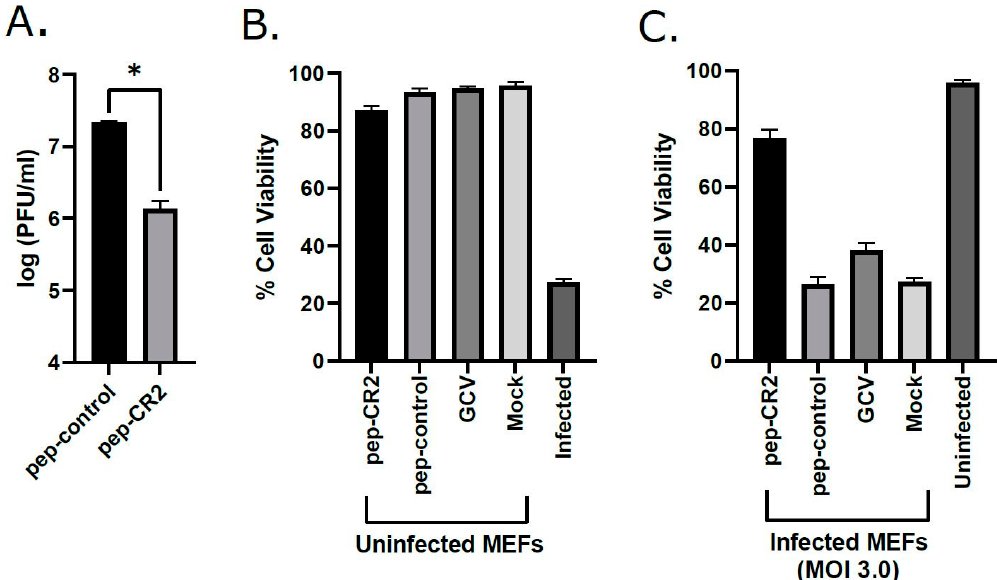
Figure 7. ( A ) Inhibition of MCMV growth upon pep-CR2 treatment. MEF cells were pretreated with 10 μ M concentration of pep-CR2 and pep-control (in triplicates) and infected with MCMV at an MOI of 3.0. Cells were harvested at 3 dpi and virus titers were assessed on MEFs. Data were analyzed by Student’s t-tests, comparing the means of pep-control and pep- CR2. Standard error of mean was plotted as error bars. A p value of <0.05 was considered significant. An asterisk (*) indicates significant inhibition compared to wild type. Cell viability (%) in ( B ) pep-CR2-treated uninfected MEFs vs. ( C ) pep-CR2-treated infected MEFs. Cells were pretreated with pep-CR2 as well as with appropriate controls (pep-control and GCV) or mock (in triplicates) for 1 h and were then either infected with MCMV at a high MOI of 3.0 or mock-infected. Cell viability was performed by trypan blue exclusion assay at 3 dpi for both groups. Results indicate that pep-CR2 protects cells from virus-induced lytic cell death. Samples were analyzed with one-way ANOVA in GraphPad Prism 9.0 and showed significant differences between groups ( p < 0.05).